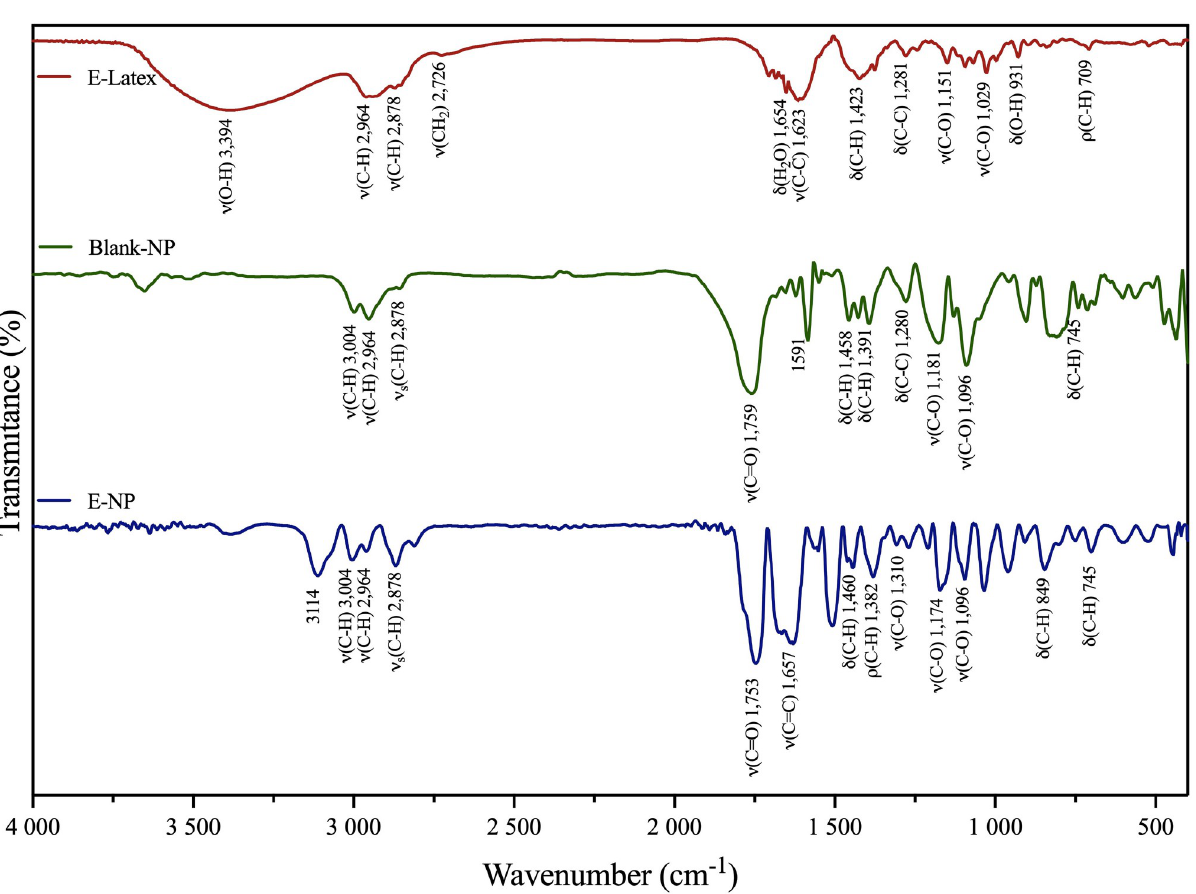
Fig 3. FTIR spectra of E-Latex (red line), Blank-NP (green line) and E-NPs (blue line).